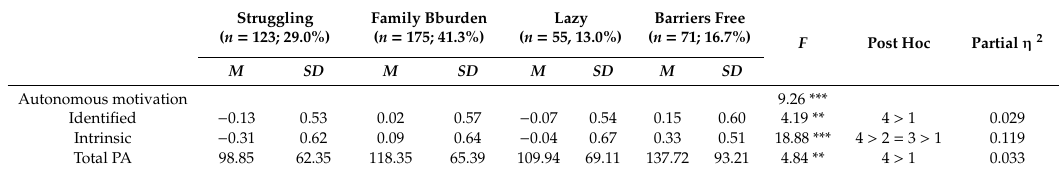
Table 5. Group di ff erences on types of physical activity endeavours 1